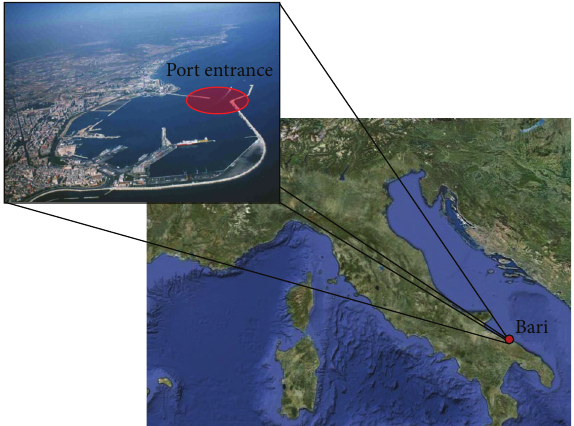
Figure 8: Port of Bari and in particular the port entrance (Image from Google